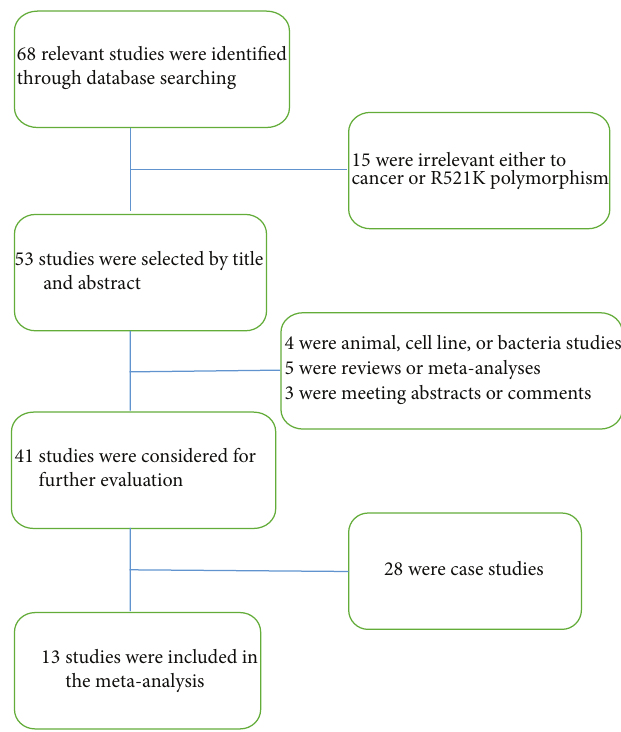
Figure 1: The flow diagram of the identification of